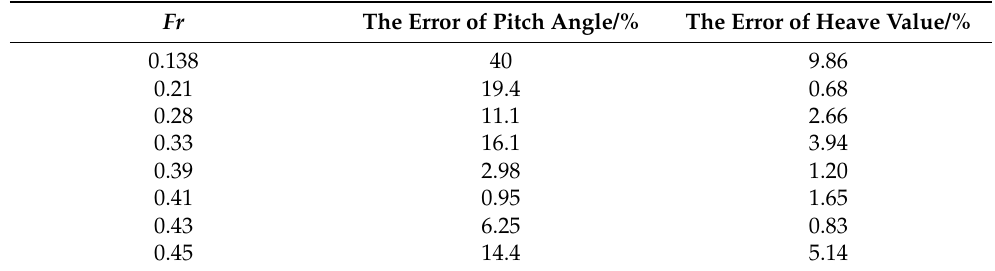
Figure 11. The comparison between the simulation model calculation results and the experimental values.